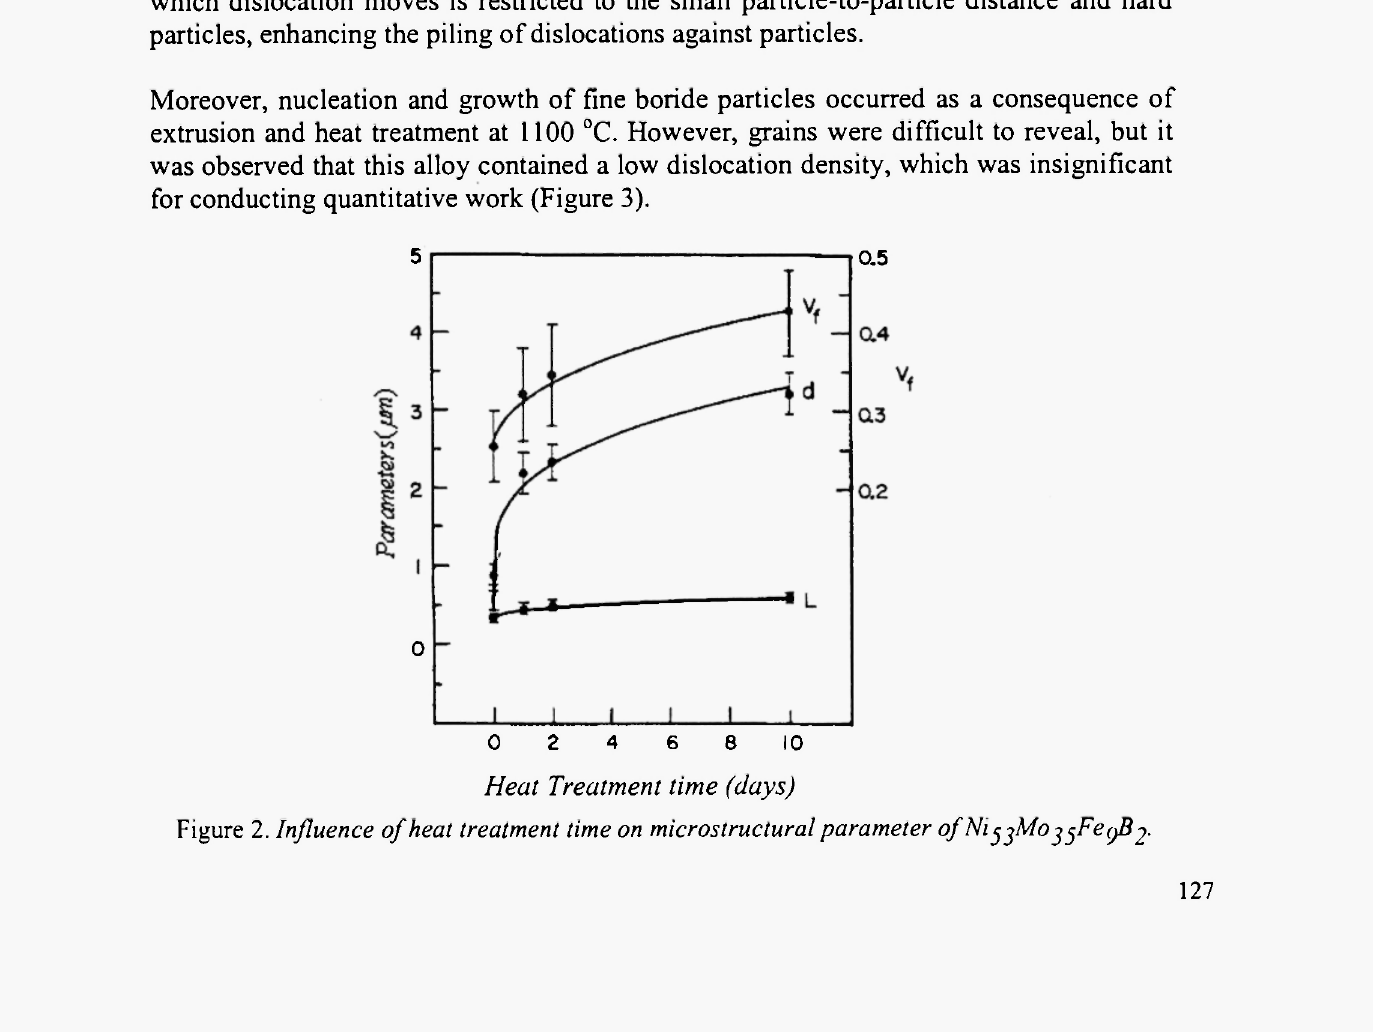
Figure 2. Influence of heat treatment time on microstructural parameter of Ni ^Mo ^Fe